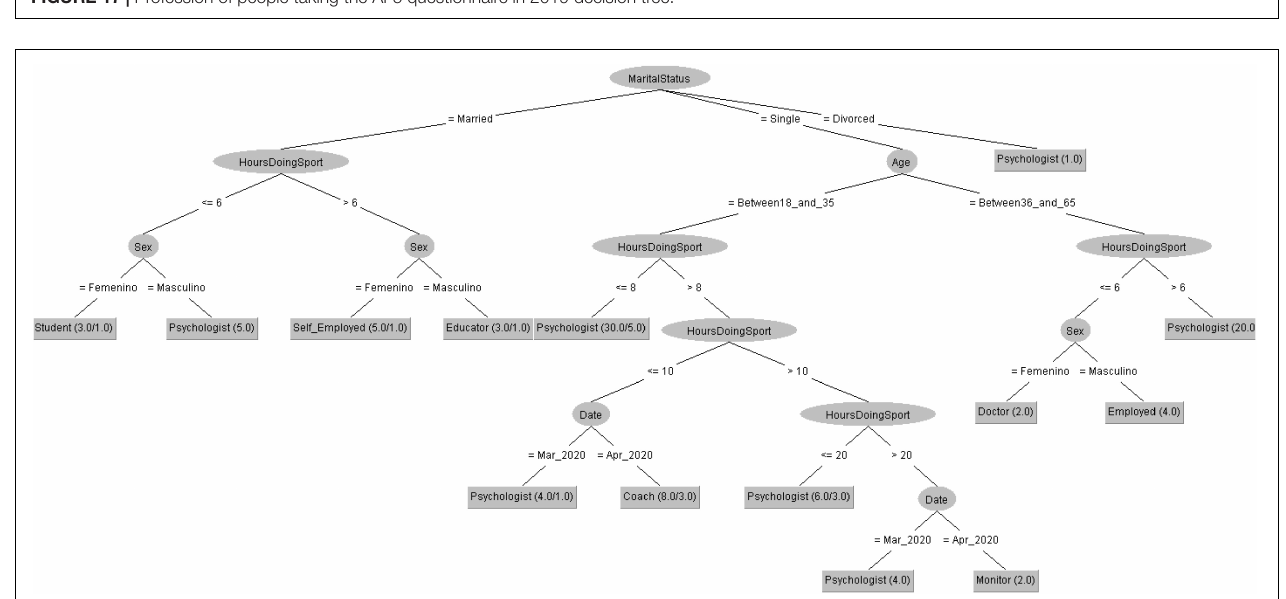
FIGURE 17 | Profession of people taking the AF5 questionnaire in 2019 decision tree.